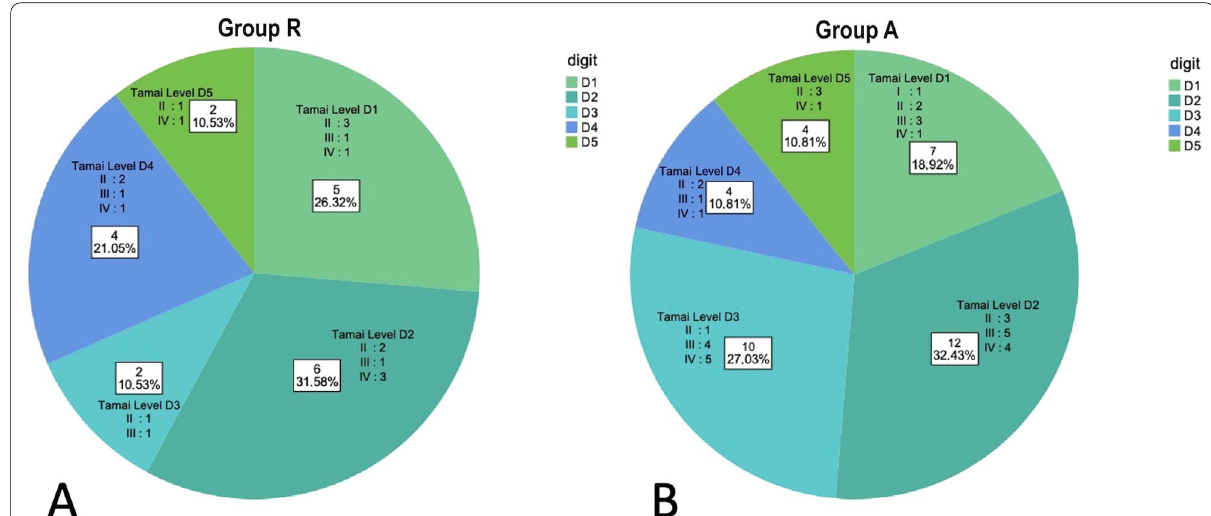
Fig. 3 Pie charts depicting the finger distributions, including the Tamai level of injury, in group R ( A ) and group A ( B ). D1 thumb, D2 index, D3 middle, D4 ring, D5 small